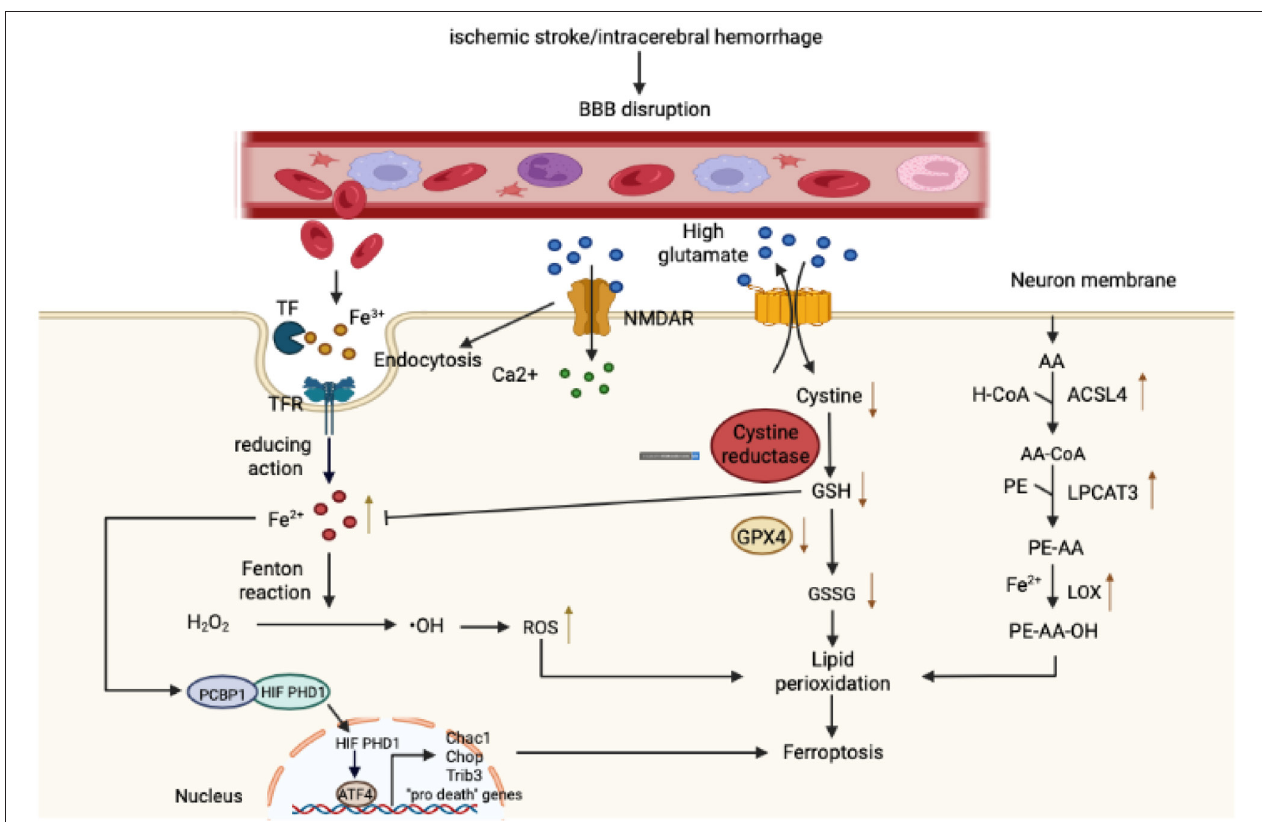
FIGURE 1 | Mechanism governing ferroptosis in stroke. With respect to iron metabolism, after ischemic or hemorrhagic stroke, the permeability of the blood-brain barrier (BBB) increases, causing a variety of components rich in Fe 3 + in the bloodstream to infiltrate into the brain parenchyma. Fe 3 + binds closely to transferrin (T) to form iron-containing TF, which then binds to TFR1 on the surface of brain cell membranes, enters cells through pinocytosis, and forms an endosome. In the acidic environment of an inclusion body, Fe 3 + is released from TF, catalyzed by ferrous reductase to Fe 2 + , and transported to the cytoplasm through the corresponding transporter. Fe 2 + then initiates the Fenton reaction to form reactive oxygen species (ROS) and also affects the catalytic activity of lipoxygenase (LOX). In addition, the Fe 2 + in the cytoplasm can be absorbed by PCBP1 and iron is loaded on the iron-free form of HIF-PDH1. Iron-containing HIF-PDH1 together with other stimuli drives the activity of pro-ferroptosis ATF4 gene expression. With regard to amino acid metabolism, a high concentration of extracellular glutamate leads to a dysfunction in system XC − , a deficiency in intracellular cystine, depletion of GSH, and diminution in GPX4 activity. In addition, glutamate binds to its receptor (NMDAR), and the activation of NMDAR then further exacerbates iron uptake. Regarding lipid metabolism, as the main component of phospholipid membranes, arachidonic acid (AA) is esterified with phosphatidylethanolamine (PE) under the action of ACSL4 and LPCAT3 to synthesize PE-AA and is then catalyzed by LOX to PE-AA-OH. As shown in the figure, these three components together lead to lipid peroxidation and